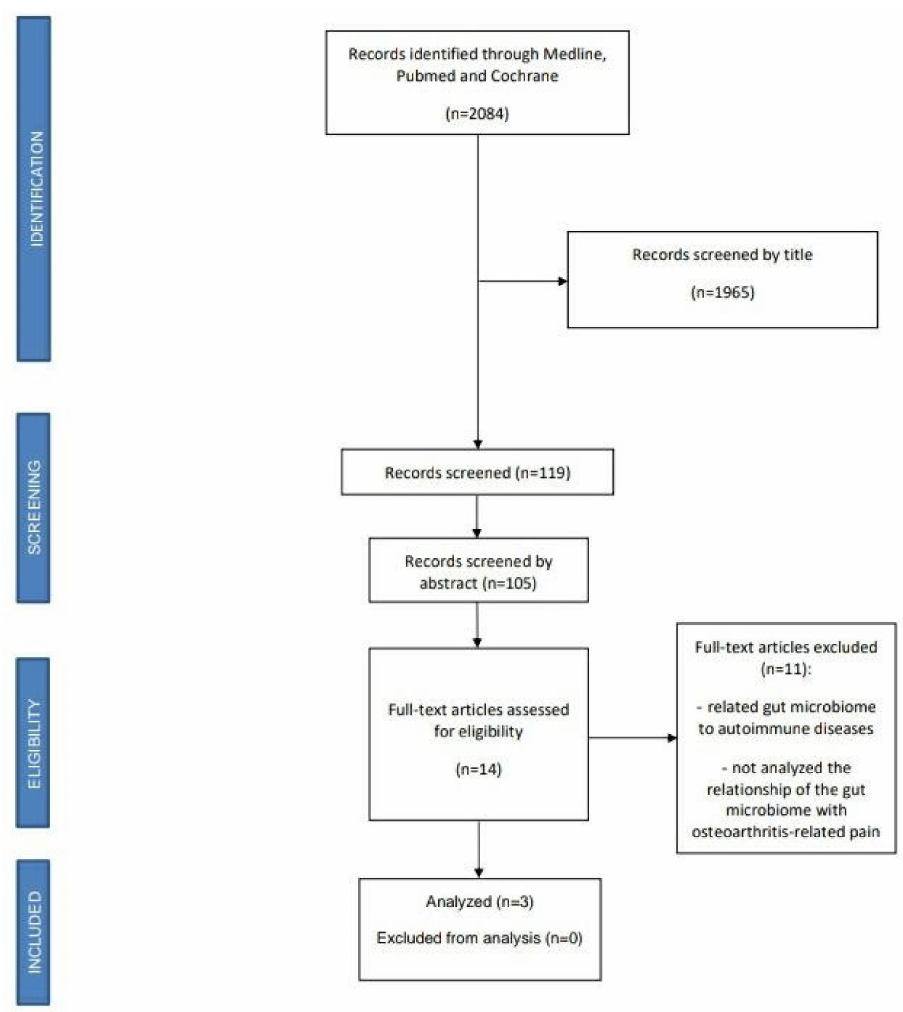
Figure 1. PRISMA flow